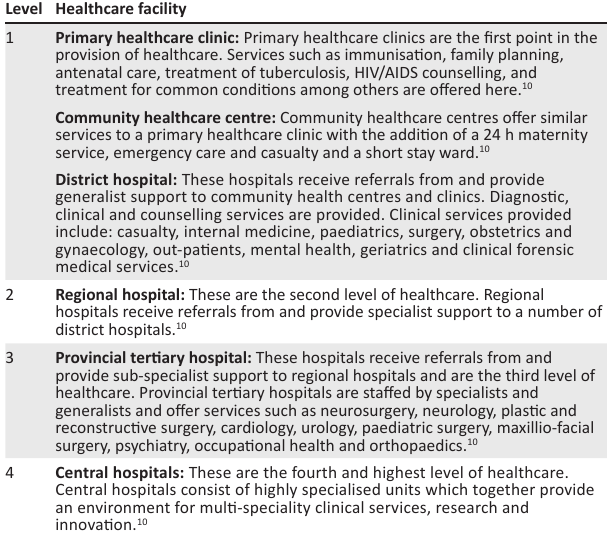
TABLE 2: Levels of healthcare in KwaZulu-Natal, South Africa. Level Healthcare